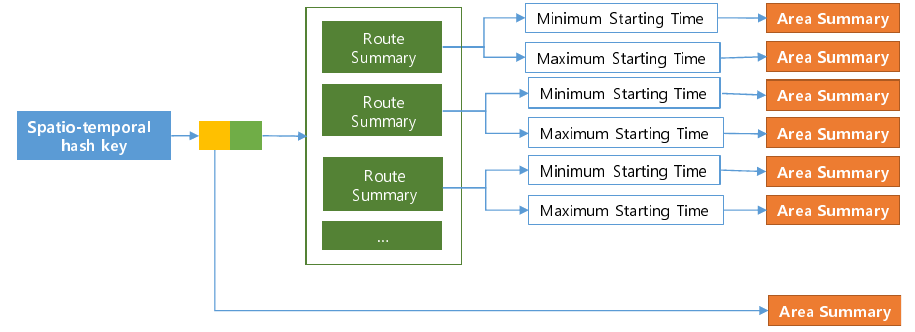
Figure 4. A conceptual view of a